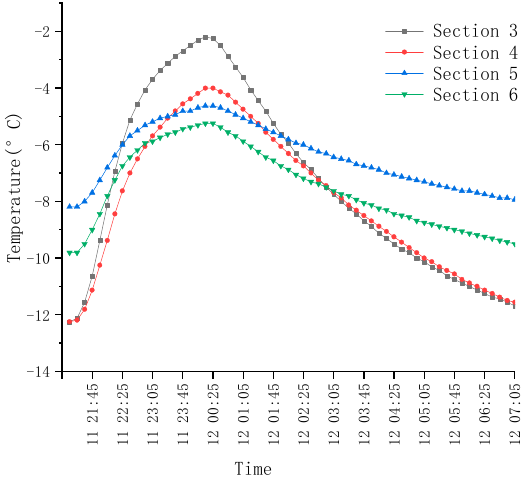
Figure 11. Temperature behind the lining.